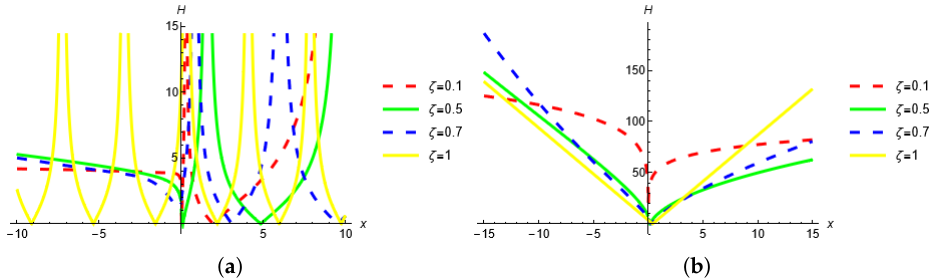
Figure 3. Influence of fractional order with H 34 ( x , t ) for the values of α = − 1, κ = 0.1, µ = 0.9, δ = 0.01, γ = − 2. ( a ) 2-D impact of fractional order ζ on solution H 1 . ( b ) 2-D impact of fractional order ζ on solution H 34 .